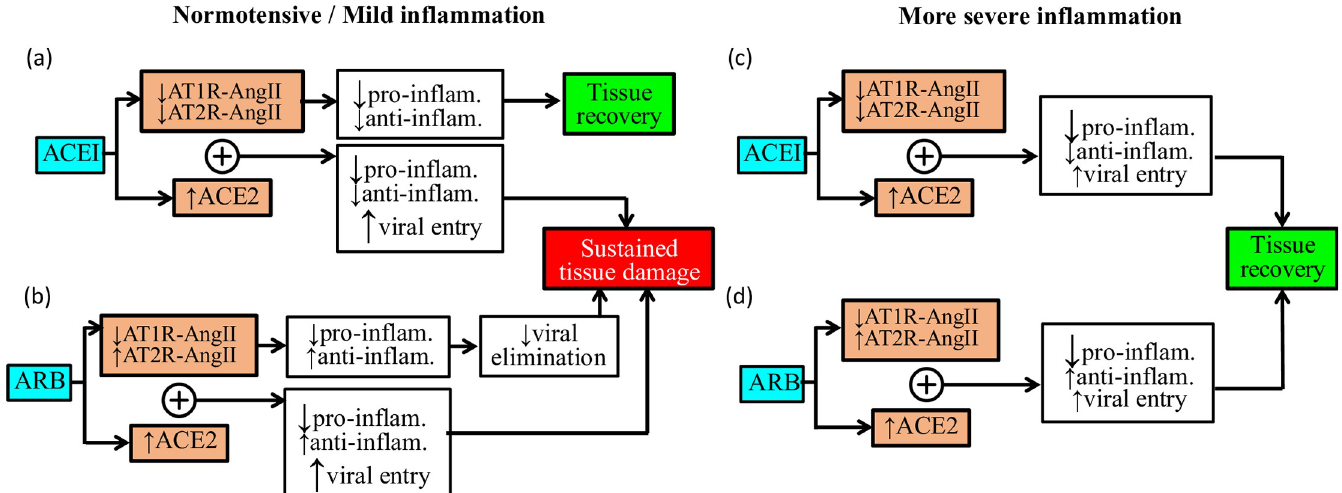
Fig 3. Schematic diagram summarizing predicted effects, and the underlying mechanisms, of ACEi (a and c) and ARB (b and d) under conditions of no or mild inflammation (a and b) or more severe inflammation (c and d).